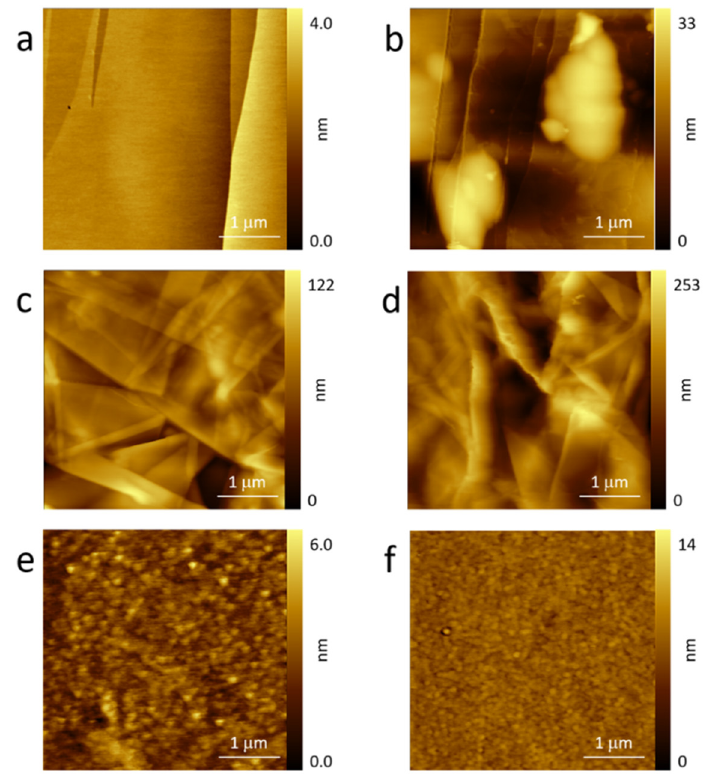
Figure 2. AFM images of the used electrodes before (HOPG ( a ); GF ( c ); GC ( e )) and after (HOPG ( b ); GF ( d ); GC ( f )) the EC treatment.